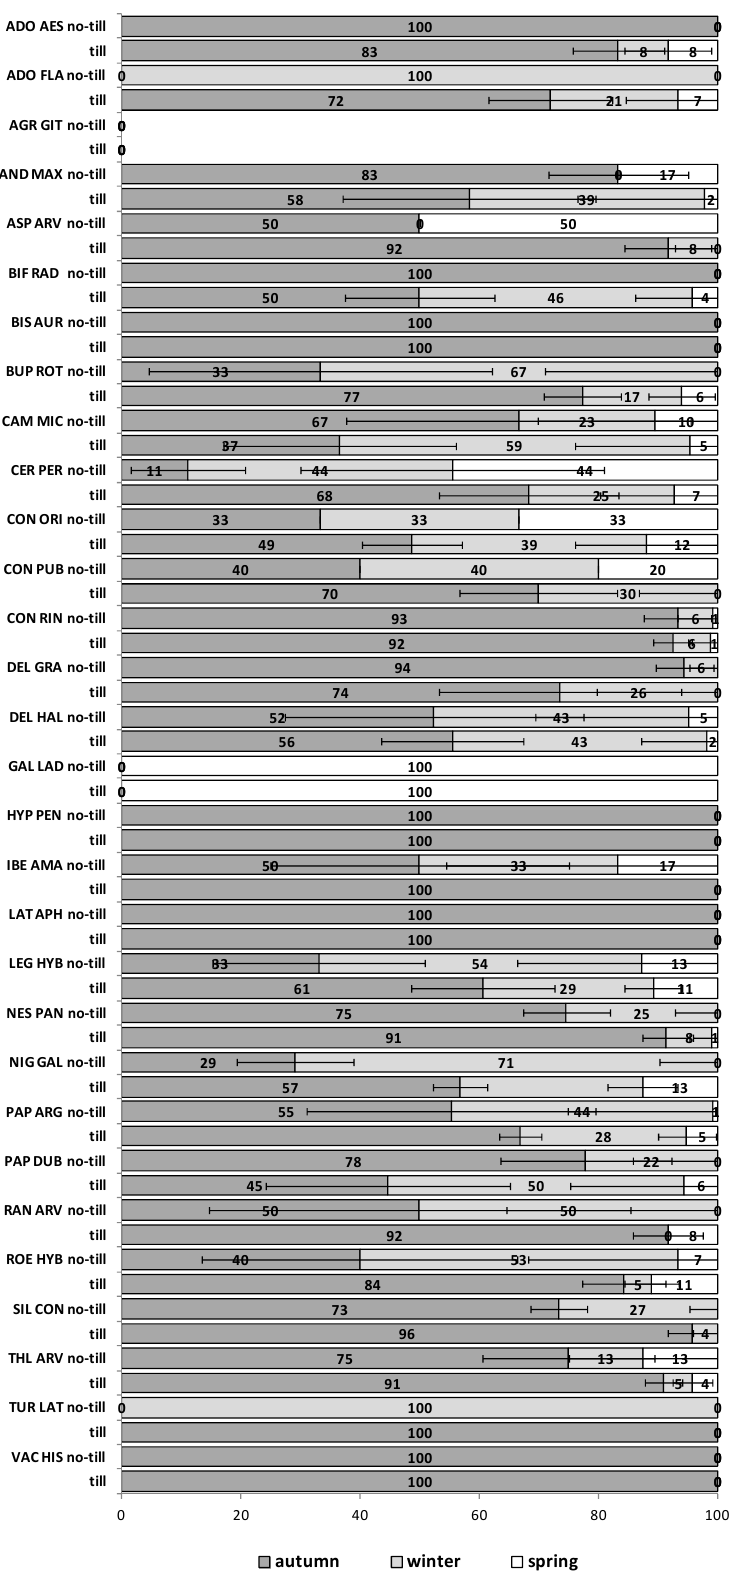
Figure A3. Relative Emergence patterns of 30 RAPs in autumn, winter, and spring during the third season (2014/2015) for seeds sown in 2012 (S1) in an arable field trial in Spain. Bars represent standard error. Two burial conditions are shown: 1 cm burial depth without soil disturbance (no-till) and 1–10 cm depth with annual autumnal soil disturbance (till).